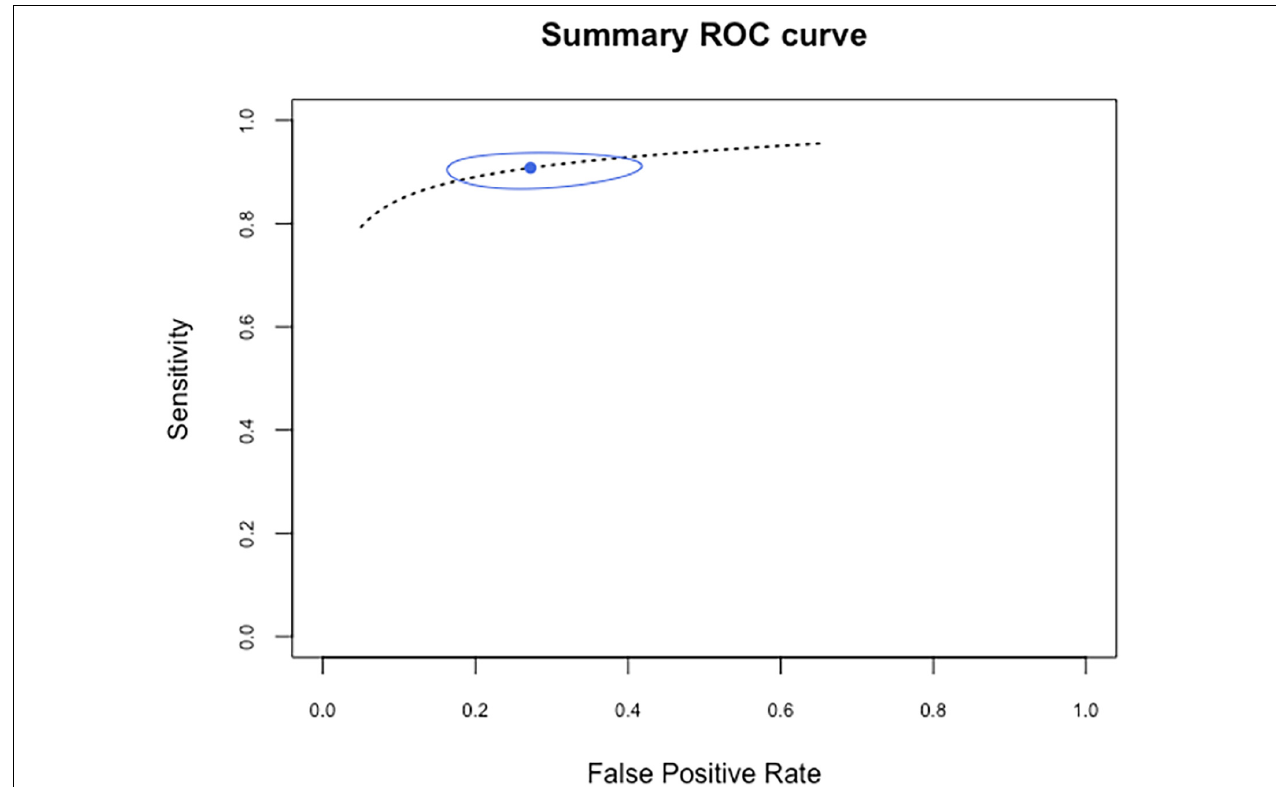
FIGURE 3 | Summary ROC curve. Estimation of diagnostic accuracy of chest CT for detection of COVID-19: high sensitivity with narrow range of variability and modest specificity (inverse of false positive rate) with a wider range of variability; attributable to variable local COVID-19 incidence and differences in reference standards